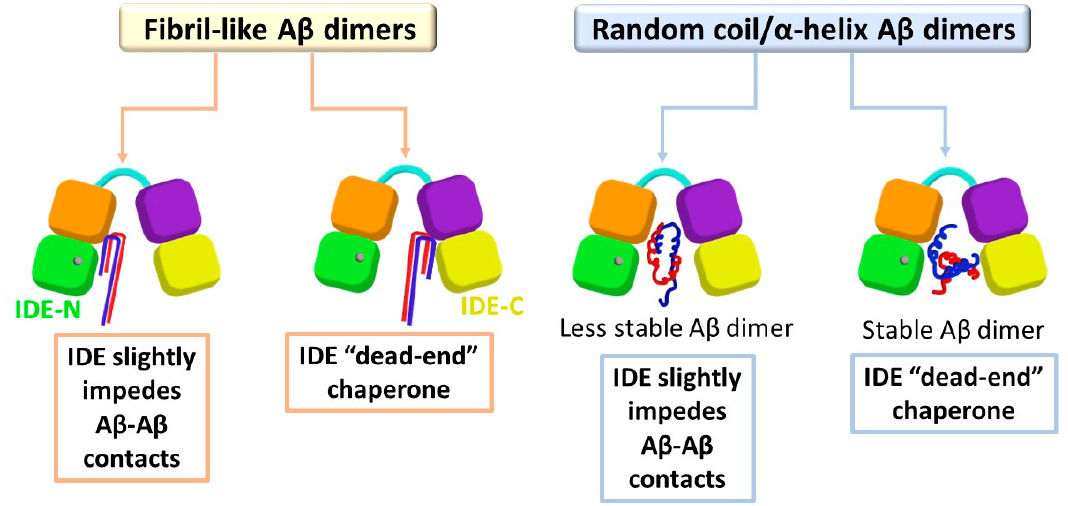
Figure 6. Proposed molecular mechanisms of the IDE effects on polymorphic A β dimers. The non-proteolytic inhibitory mechanism slightly impedes the contacts between the monomers. The “dead-end” chaperone activity produces an encapsulated A β dimer inside the IDE chamber. Supplementary Materials: The following supporting information can be downloaded at: https: //www.mdpi.com/article/10.3390/biom12121886/s1, Figure S1: Three initial minimized structures of IDE-A β fibril-like dimer complexes; Figure S2: The residues of IDE within the four domains that bind residues in A β fibril-like dimer in three models (F1, F2 and F3); Figure S3: Four initial minimized structures of IDE-A β random coil/ α -helix dimer complexes; Figure S4: The residues of IDE within the four domains that bind residues in A β random coil/ α -helix dimer in four models (R1, R2, R3 and R4); Figure S5: The root-mean-square deviations (RMSDs) values of IDE domains for F1–F3 models; Figure S6: The root-mean-square deviations (RMSDs) values of IDE domains for R1–R4 models; Figure S7: The root-mean-square deviations (RMSDs) values for A β dimers for models F1–F3; Figure S8: Root-mean-square fluctuations (RMSFs) of A β monomers within each dimer in models F1–F3; Figure S9: Percentage occurrence maps of hydrophobic interactions between two fibril-like A β monomers; Figure S10: DSSP analysis of the location of β -strands along the sequence of fibril-like A β monomers; Figure S11: The root-mean-square deviations (RMSDs) values for A β dimers for models R1–R4; Figure S12: Root-mean-square fluctuations (RMSFs) of A β monomers within each dimer in models R1–R4; Figure S13: Structure of A β dimer in models D1 and R1, and percentage occurrence maps of hydrophobic interactions between two A β monomers; Figure S14: Structure of A β dimer in models D1 and R2, and percentage occurrence maps of hydrophobic interactions between two A β monomers; Figure S15: Structure of A β dimer in models D4 and R3, and percentage occurrence maps of hydrophobic interactions between two A β monomers; Figure S16: Structure of A β dimer in models D4 and R4, and percentage occurrence maps of hydrophobic interactions between two A β monomers; Figure S17: DSSP analysis of the location of α -helices along the sequence of A β monomers in models R1–R4; Figure S18: Total number of hydrogen bonds between IDE and A β monomers for all models; Figure S19: Total number of electrostatic interactions between negative residues and positive residues of IDE to A β monomers for all models; Figure S20: Solvation by water molecules of IDE for all models; Figure S21: Solvation by water molecules of A β monomers for all models. Author Contributions: Constructed the models and ran the simulations, collected the data, and analyzed the data, K.A.-H.; Wrote the original draft, K.A.-H. and Y.M.; Designed the research and revised the manuscript, Y.M. All authors have read and agreed to the published version of the